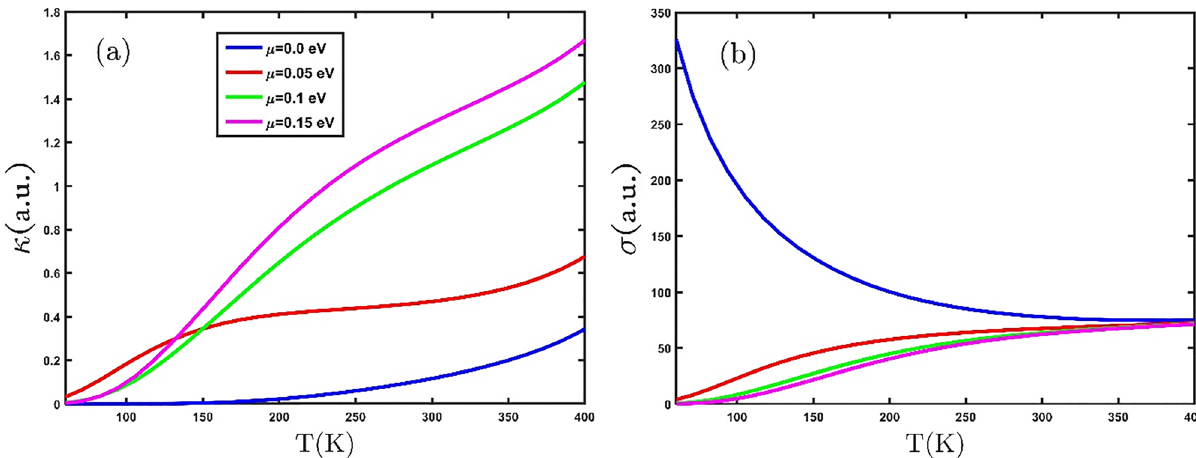
Figure 8. ( a ) The electronic thermal conductivity and ( b ) electrical conductivity of the GeCH 3 SL under the effect of electron doping in terms of